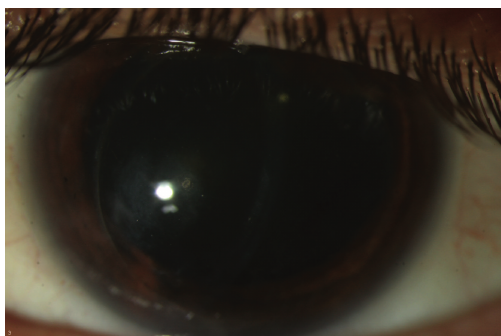
Figure 1: Slit lamp photo showing corneal edema and vertical opaque lines at the level of Descemet’s membrane.